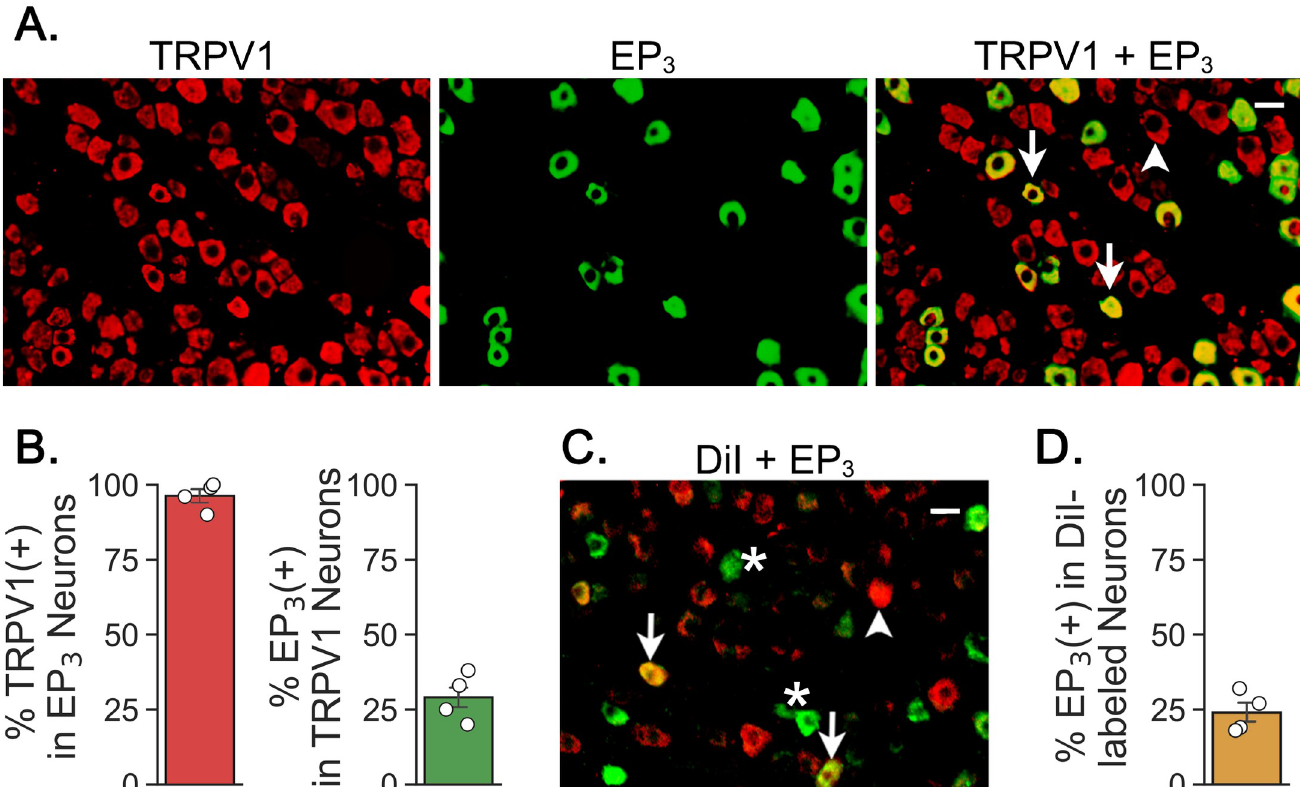
Fig 3. Co-expression of TRPV1 and EP3 or DiI and EP3 in nodose ganglion neurons. A: Nodose ganglionic neurons single-labeled with TRPV1 (left) or EP3 (middle) and double-labeled with TRPV1+EP3 (right). Arrows and arrowhead point to the double- and single-labeled neuron(s) respectively. Bar = 25 μ m. B: The corresponding group data show that almost all EP3-labeled neurons co-express TRPV1 and 31% of TRPV1 neurons are co-labeled with EP3 (n = 4). C: Nodose ganglionic neurons single-labeled with EP3 or DiI (green or red, as marked by “ � ” or arrowhead) and double-labeled with EP3+DiI as pointed by arrows. D: Group data showing that 24% of DiI-labeled neurons are co-labeled with EP3 (n = 4).